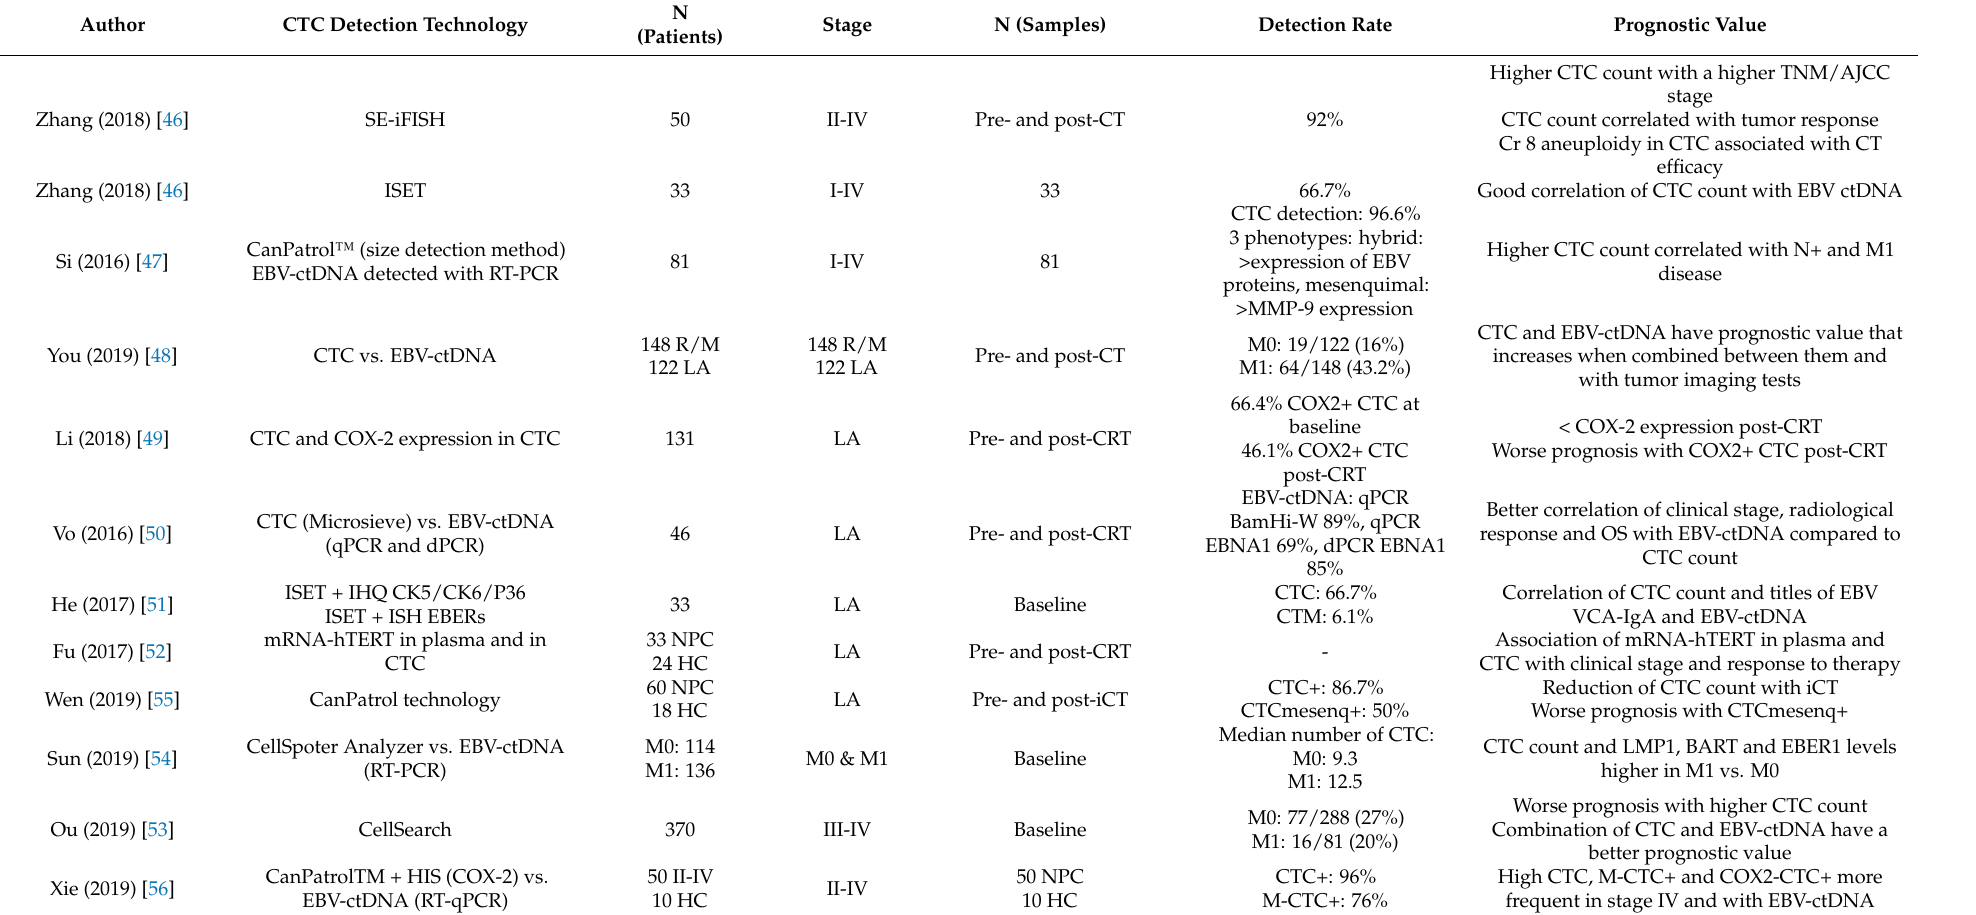
Table 2. Most relevant studies with CTC in patients with EBV+